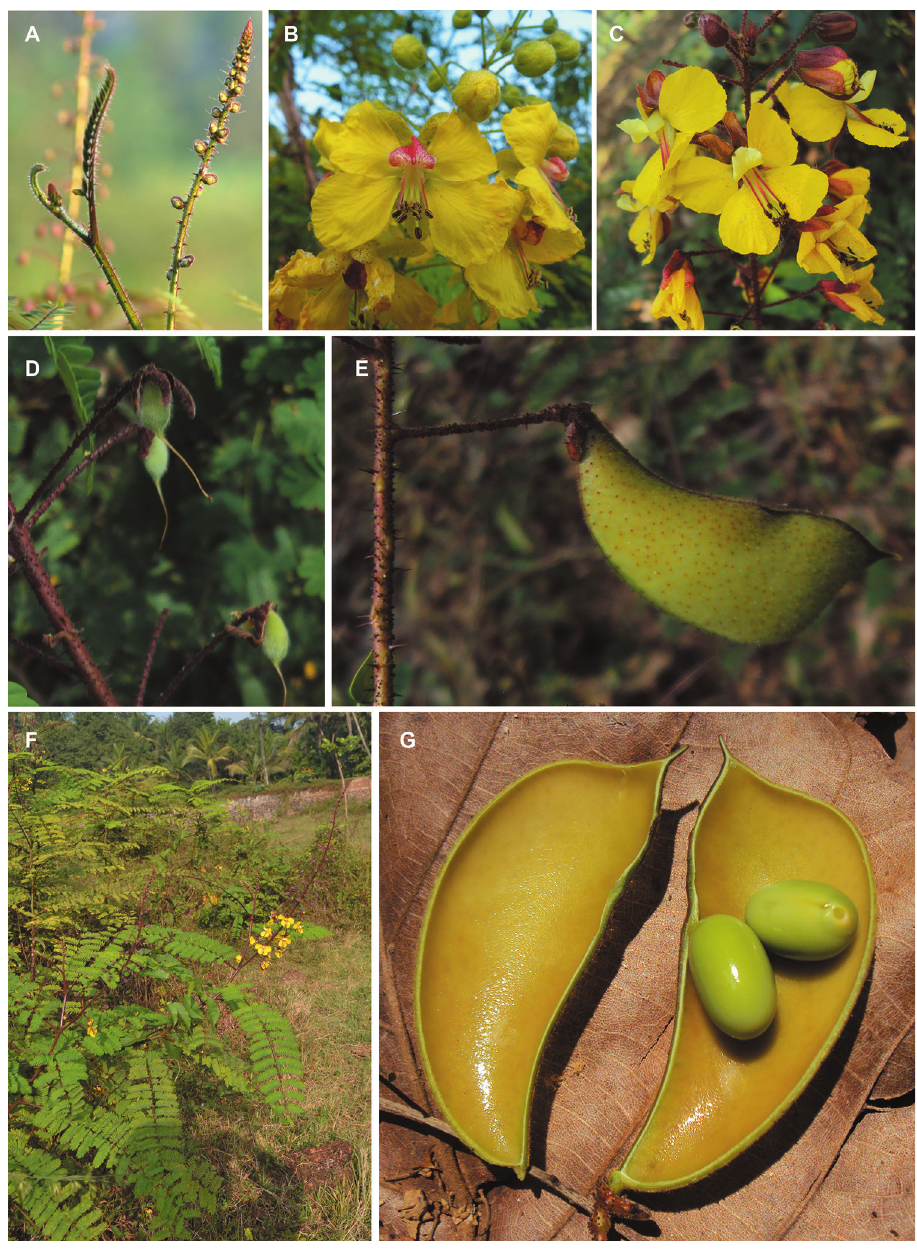
Figure 18. Hultholia mimosoides (Lam.) E. Gagnon & G. P. Lewis. A young leaves and inflorescence in bud (J. Jose, Wikicommons (https://commons.wikimedia.org/wiki/File:Caesalpinia_mimosoides_2_ at_Kudayathoor.jpg), Kerala, India, unvouchered ) B flower (R. Clark, Thailand, Clark et al. 237 (K)) C flowers D immature fruits E mature fruit F habit G open fruit with seeds (V. R. Vinayaraj, Wikicom- mons (https://commons.wikimedia.org/wiki/Category: Caesalpinia_mimosoides, the basionym of Hulth- olia mimosoides ), India, unvouchered